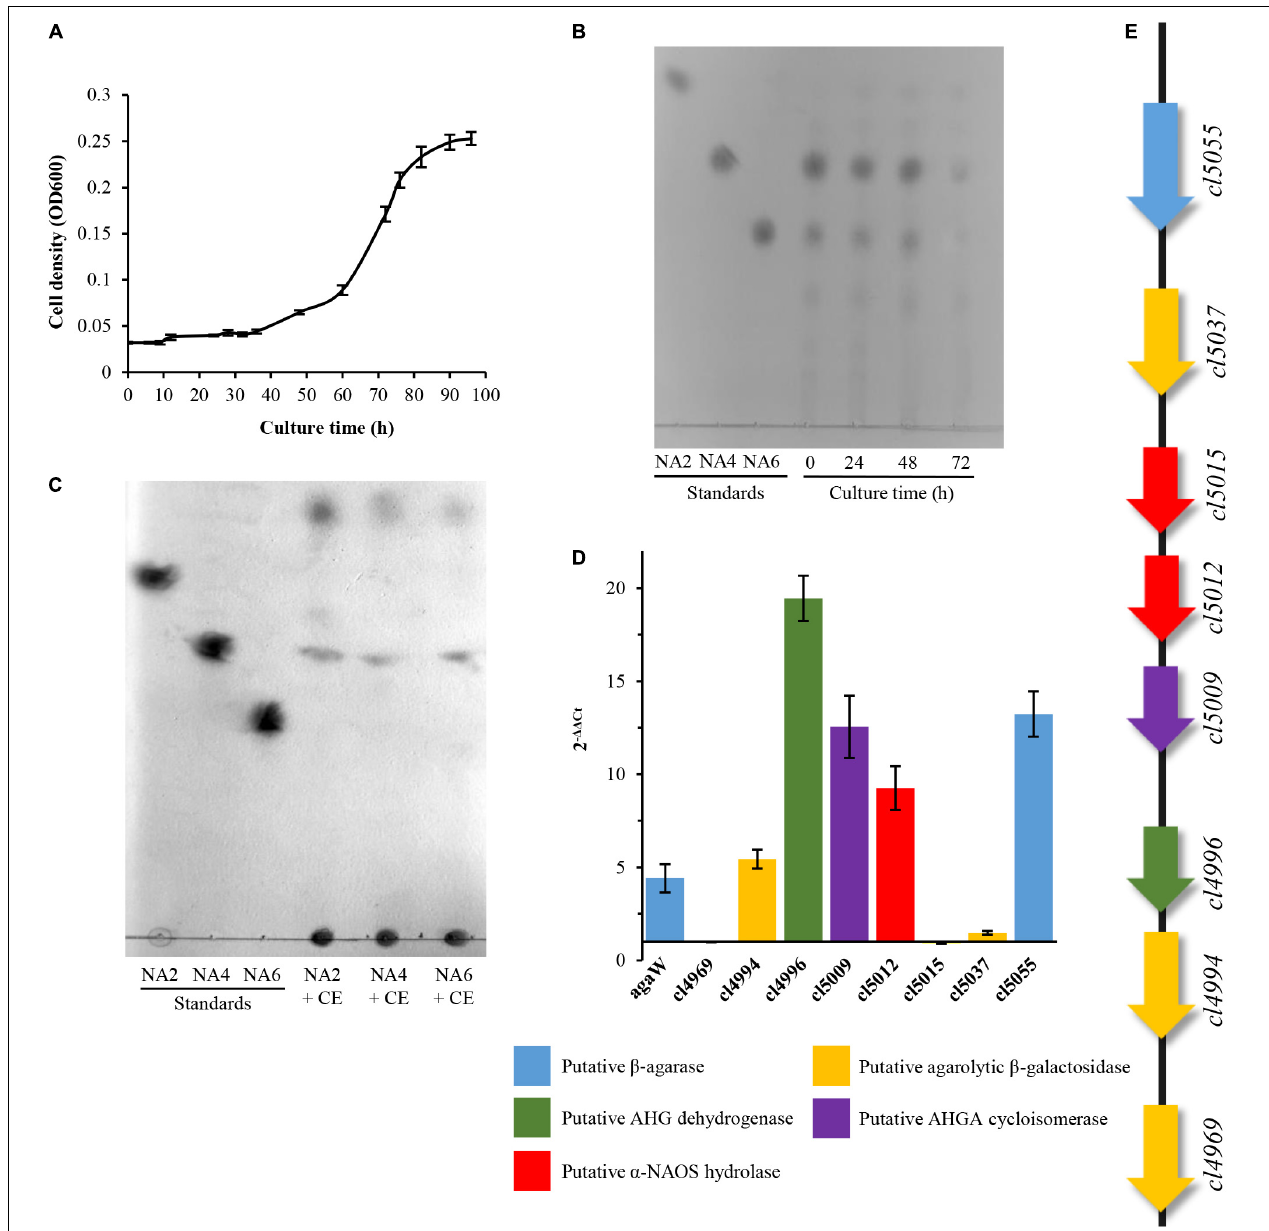
FIGURE 1 | Utilization of NAOSs by Cohnella sp. LGH and qPCR analysis of agarolytic candidate genes. (A) Growth curve of strain LGH cultured by NAOS medium. (B) TLC analysis of residual NAOSs from liquid medium. (C) TLC analysis of crude enzyme incubated with neoagarobiose, neoagarotetraose, and neoagarohexaose. (D) qPCR analysis of relative quantification of eight candidate genes involved in agarolytic pathway. The mean values and standard deviations were calculated by three replicate experiments. (E) Cluster of putative functional genes involving in agarose catabolism of strain LGH. AHG, 3,6-anhydro-L-galactose; AHGA, 3,6-anhydro-galactonate; CE, crude enzyme; NA2, neoagarobiose; NA4, neoagarotetraose; NA6, neoagarohexaose; NAOS, and